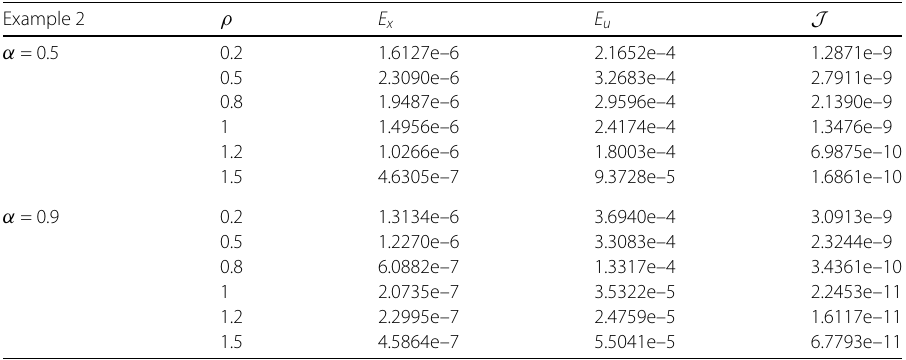
Table 8 The maximum absolute errors E x and E u at N = 7 and various values of α , ρ for x ( t ) and u ( t ), respectively Example 2 ρ E x E u J α = 0.5 0.2